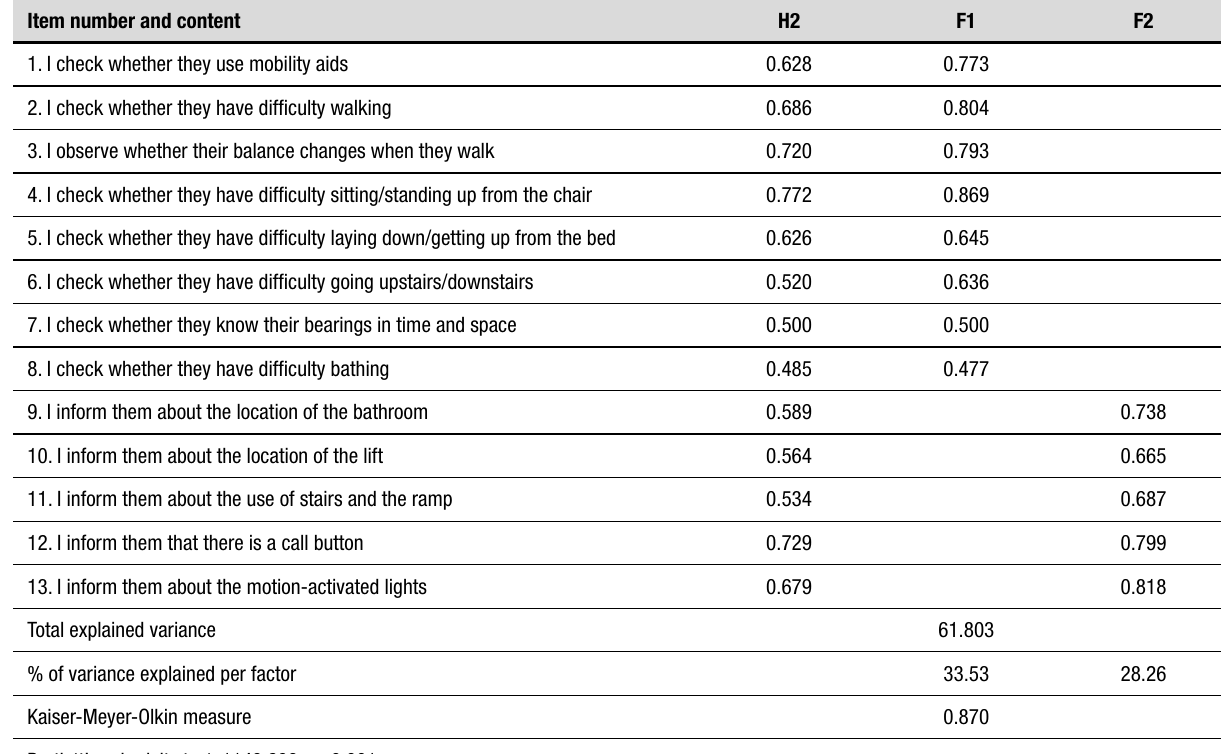
Table 2. Matrix of main components after the Varimax rotation of the 13 items of the Scale for Practices of Identification of and Information on Fall Risk Factors in the Admission of Older Adults. Lisbon,